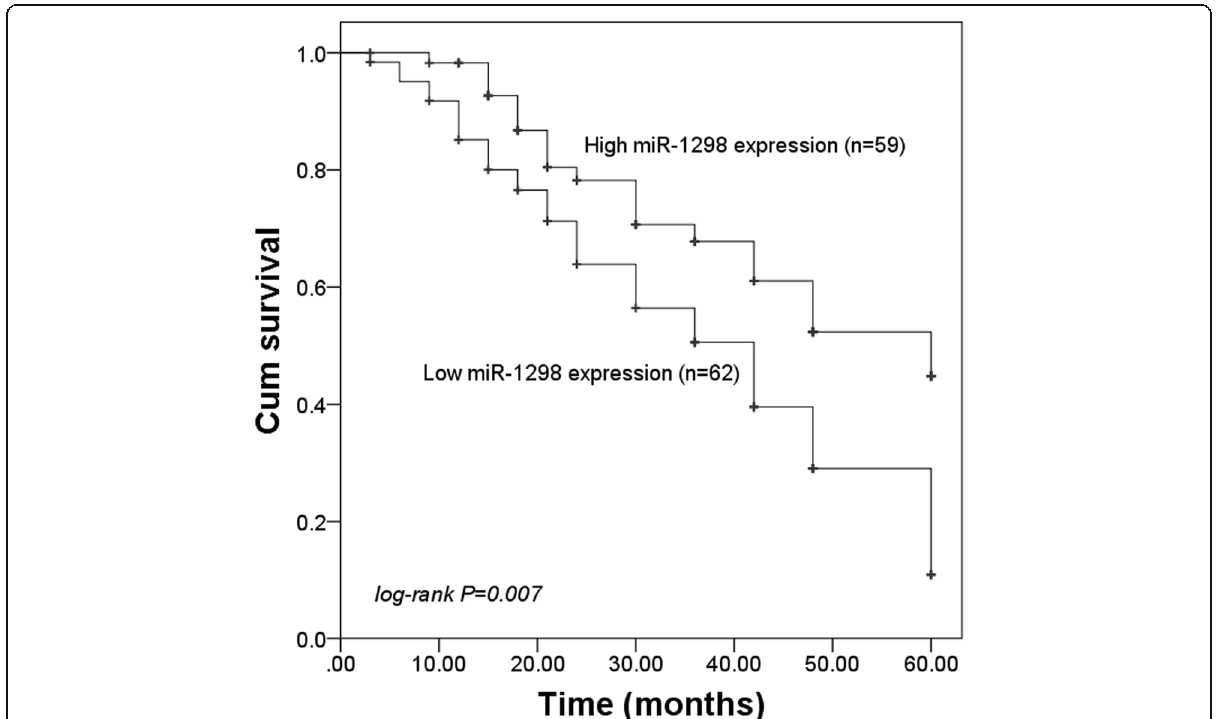
compared with the high miR-1298 expression. Log-rank P = 0.007